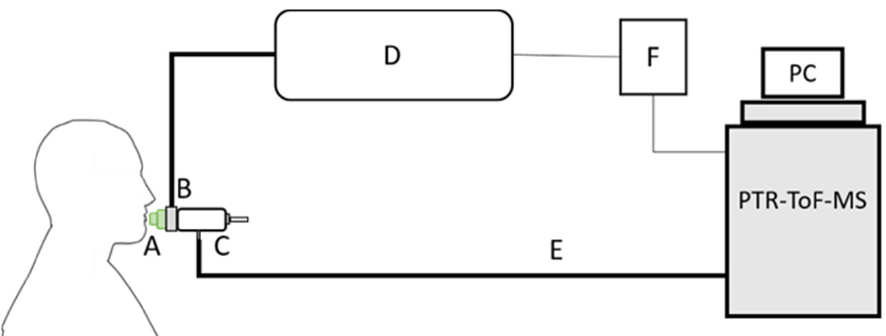
Figure 6. Schematic diagram of the breath sampling setup. Participants exhaled through a bacterial mouth filter ( A ) connected to a CO 2 sensor ( B ) into a heated buffer pipe ( C ) at a constant flow of 50 ml/sec following a visual indicator on the screen of the breath sampler ( D ) for as long as was comfortable. The pipe is connected to the proton transfer reaction time-of-flight mass spectrometry (PTR-ToF-MS) via a heated sampling line ( E ). When the CO 2 concentration reached 4%, a CO 2 -flow monitoring trigger signal ( F ) was sent to the PTR-ToF-MS to aid with data processing.